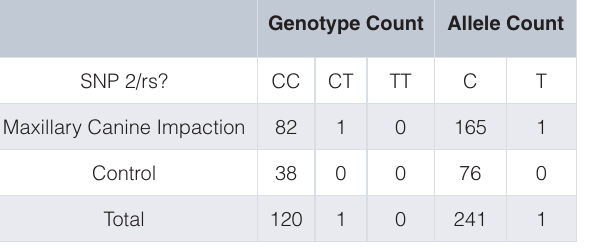
Table 7. Genotype analysis of SNP 4 in case and control samples.